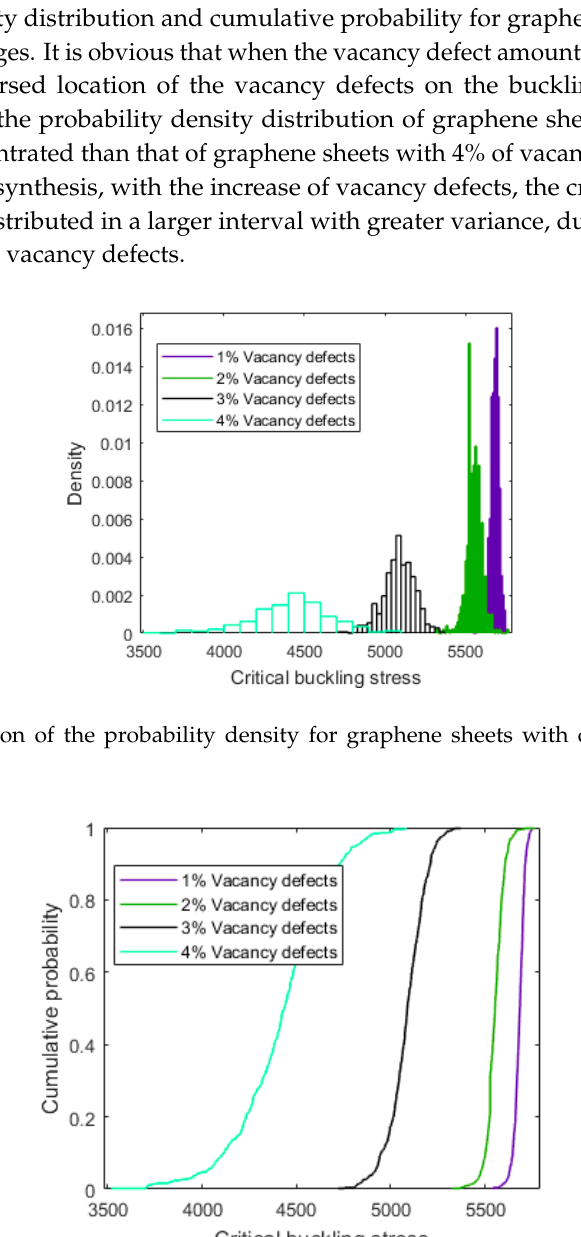
Figure 3. The probability density distribution for different amounts of vacancy defects. The samples ( a – d) represent 1%, 2%, 3%, and 4% of vacancy defects, respectively.